Question: In one sentence, what is this figure communicating?
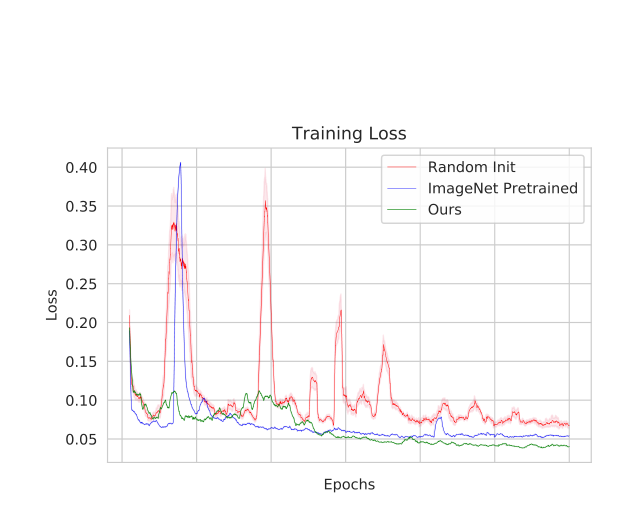
Answer: Training loss of building segmentation on T2, with three different network initializations. Random Init refers to initializing the network from random weights, ImageNet pre- training refers to initializing the network with weights from training on ImageNet classification. Ours refers to initializing the network with weights pretrained on terrain prediction task.